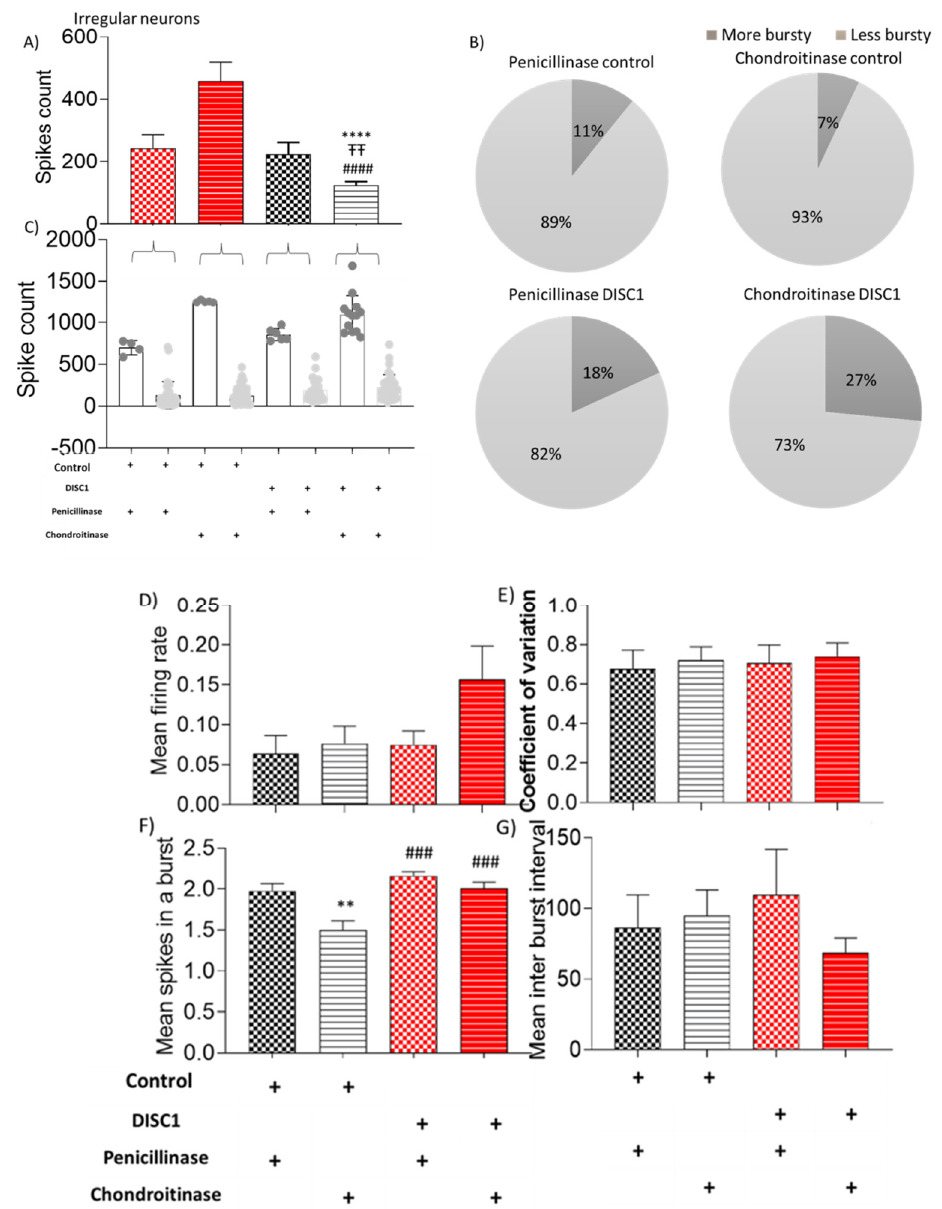
Figure 3. Analysis of immunofluorescence of chondroitinase and penicillinase treated animals PFC. ( A , B ) representative images of DAPI (blue), PNN (red), PV (green), and merged stains for animals treated at 8 weeks old. Panel A illustrates control animals treated with Penicillinase (P) or Chondroitinase (ChABC), while Panel B shows the results for 129S animals; ( C – E ) quantitative analysis of PNN, PV, and their colocalization in layer 2/3 of PFC; ( F – H ) quantitative analysis of PNNs, PVs, and their colocalization in layer 5/6 of PFC. The top graphs show the density of PNNs (PNN count/area), the middle graphs indicate the density of parvalbumin neurons (PVB/unit area) and the bottom graphs indicate the density of colocalized PNNs with PVBs. The treatment groups are indicated in the x -axis legends below each column of graphs. Black and red bars represent control and DISC1 mutation background, respectively. The data are represented as plots showing mean ± s.e.m. where * or # p ≤ 0.05, ** or ## p ≤ 0.01, *** p ≤ 0.001 and **** or #### p ≤ 0.0001, where the symbols express the comparison of chDISC1 mutation animals with * represents comparison vs. penicillinase control, # represents comparison vs. chondroitinase control, and “ Ŧ ” represents comparison vs. Penicillinase treated